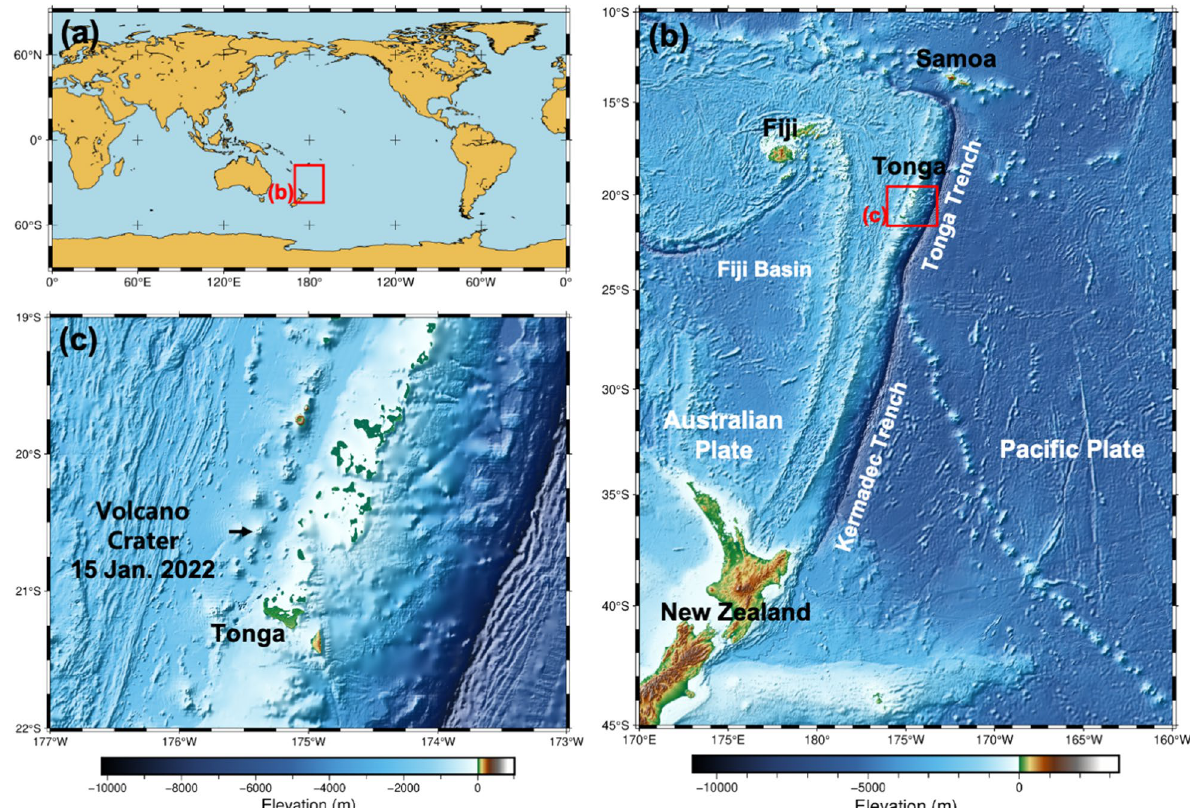
Fig. 1 a World map, b Map of the Tonga volcanic arc showing the location of Hunga Tonga–Hunga Ha’apai volcano relative to the Tonga– Kermadec arc-trench system, and c Tonga volcano crater and main islands in the Kingdom of